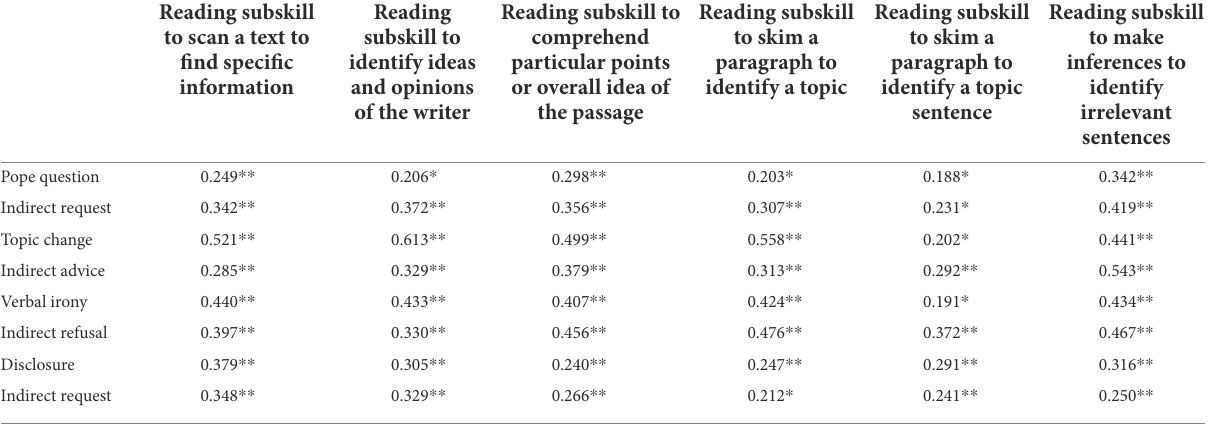
TABLE 6 Correlation between reading test subskills and conversational implicature